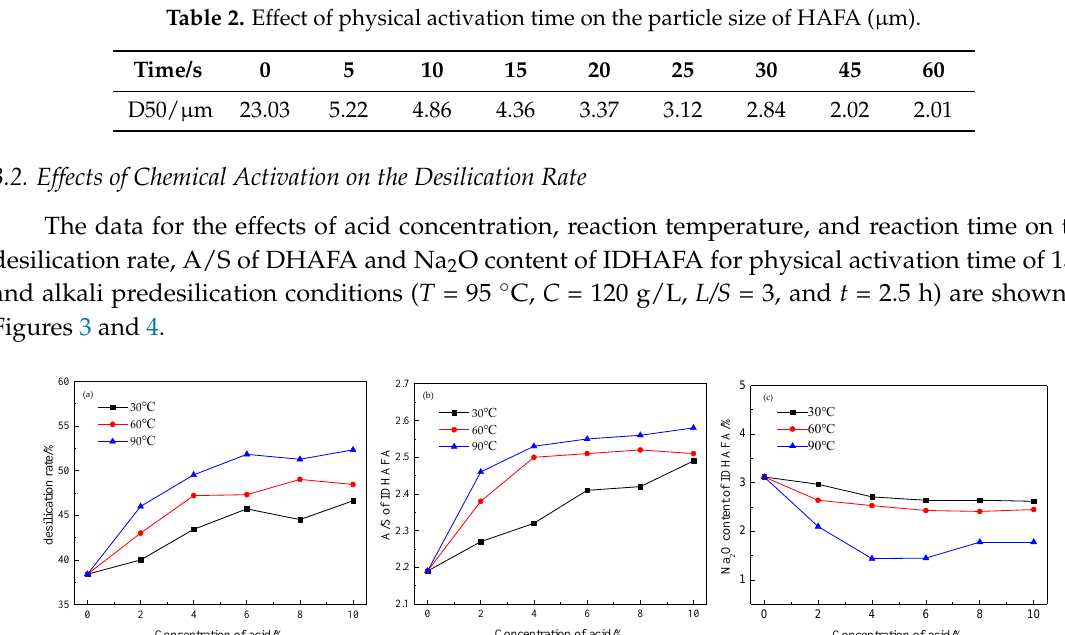
Figure 3. Effect of concentration of acid: ( a ) desilication rate, ( b ) A/S of intensified desilicated high alumina fly ash (IDHAFA), ( c ) Na 2 O content of IDHAFA.